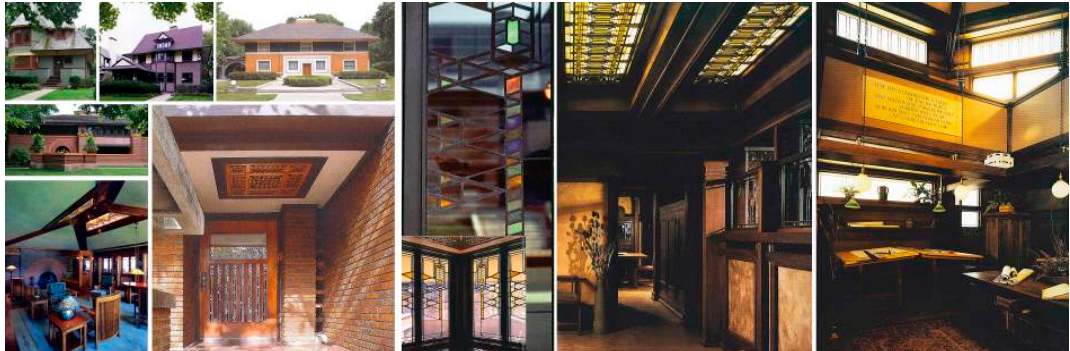
Figure 7. Images of Wright’s Architecture in the Oak Park and River Forest districts. From sn to the top: Thomas H. Gale House (1892), Harry C. Goodrich House (1896), William H. Winslow House (1894); from below: Arthur B. Heurtley House (1902)—External and Internal View—Harry S. Adams House (1913); in the middle the colorful stained glass windows of Robie House’s dining room; on the right, the Wright’s home-office and drawing room in the Oak Park District